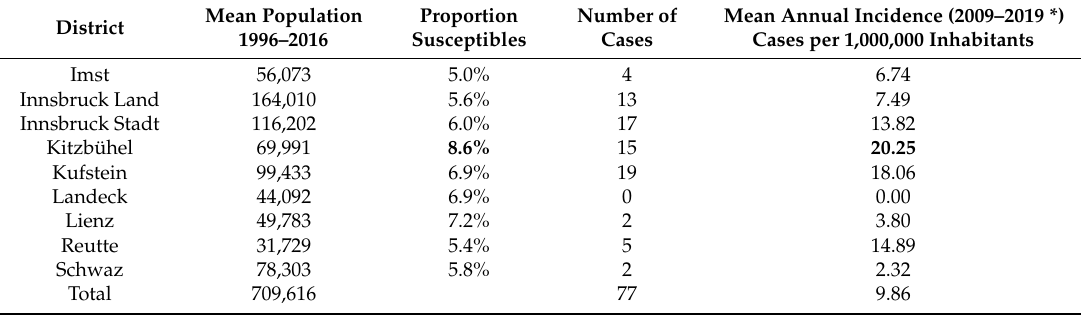
Table 4. Population, proportion of susceptibles of the serosurvey and cumulative incidence 2009–2016 by